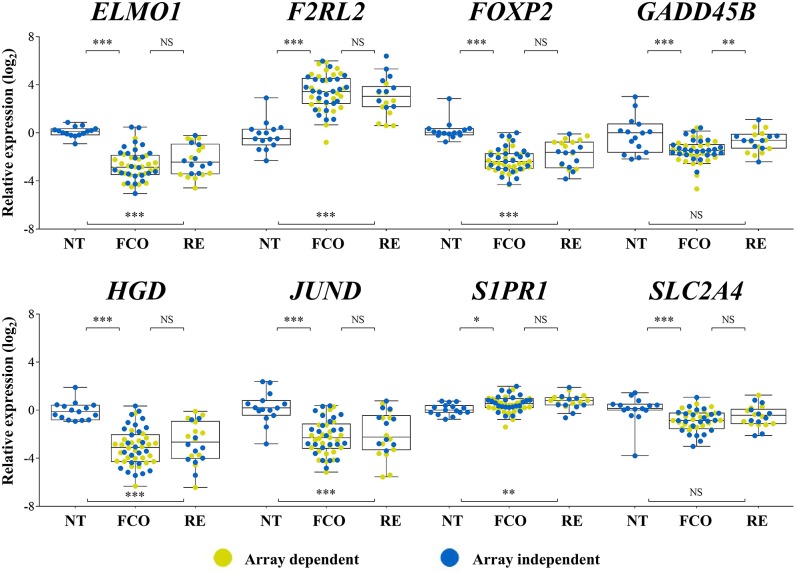
Expression levels of eight genes evaluated by RT-qPCR (TLDA custom assay) in PTC samples previously investigated by microarray analysis (yellow dots) and in an array-independent set of samples (blue dots). GADD45B showed statistically significant higher expression levels in PTC-RE compared to PTC-FCO cases. FCO, favorable clinical outcome; RE, recurrence; ***P < 0.001; **P < 0.01; *P < 0.05; NS, not significant (Tukey post-hoc test).